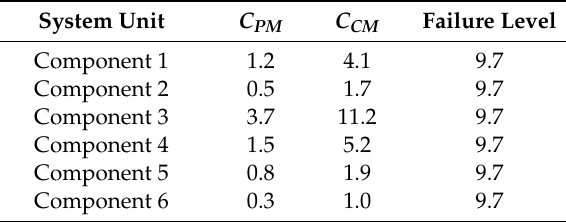
Table 2. Maintenance data.